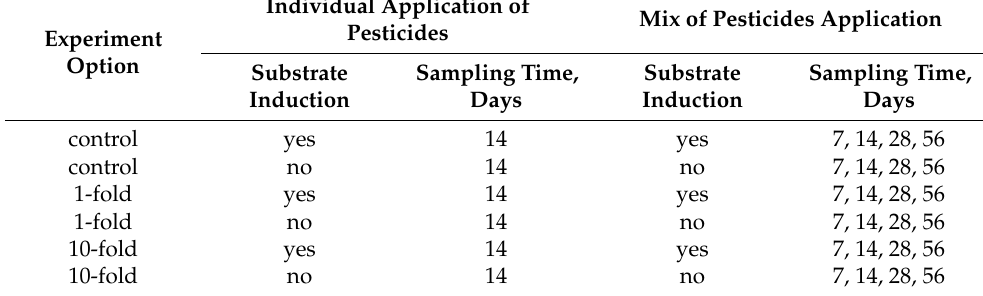
Table 3. Experimental